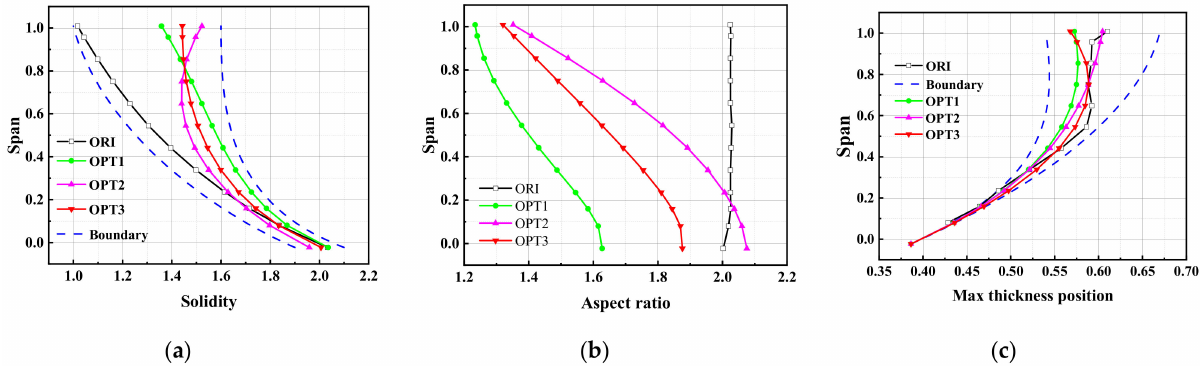
Figure 10. Spanwise distributions of geometric parameters for optimized samples: ( a ) solidity; ( b ) aspect ratio; ( c ) max thickness position.